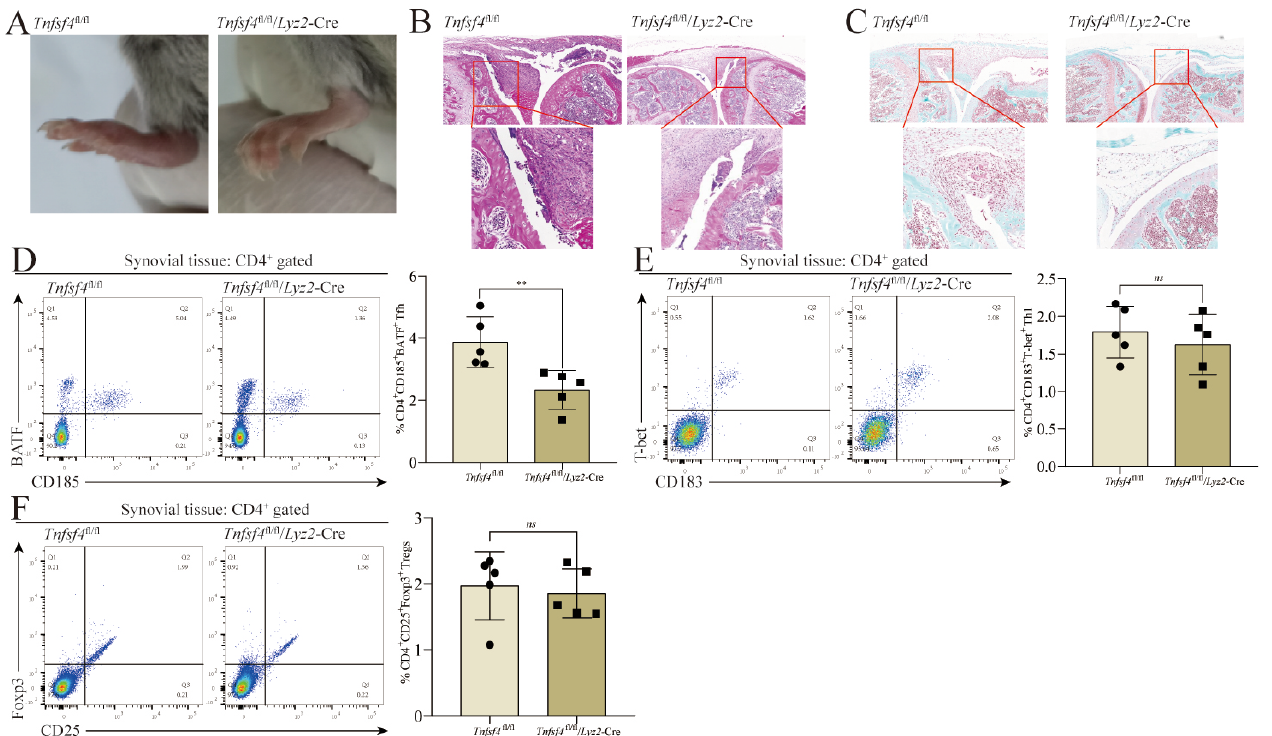
Figure 4. The differentiation of Tfh requires SMs to express OX40L in the joint microenvironment of CIA mice, while Th1 and Tregs do not. ( A ) Photographs of the paw of Tnfsf4 fl/fl / Lyz2 -Cre mice and Tnfsf4 fl/fl mice on day 49. ( B ) H&E staining of the knee of Tnfsf4 fl/fl / Lyz2 -Cre mice and Tnfsf4 fl/fl mice on day 49. ( C ) SafraninO-fast green staining of the knee of Tnfsf4 fl/fl / Lyz2 -Cre mice and Tnfsf4 fl/fl mice on day 49. ( D ) The proportion of CD185 + BATF + Tfh in CD4 + T cells in the synovial tissues. ( E ) The proportion of CD183 + T-bet + Th1 in CD4 + T cells in the synovial tissues. ( F ) The proportion of CD25 + Foxp3 + Tregs in CD4 + T cells in the synovial tissues. ** p < 0.01 represents a significant difference between the Tnfsf4 fl/fl / Lyz2 -Cre group and the Tnfsf4 fl/fl group, and ns means no significant difference. Data represent mean ± SD (unpaired t test was